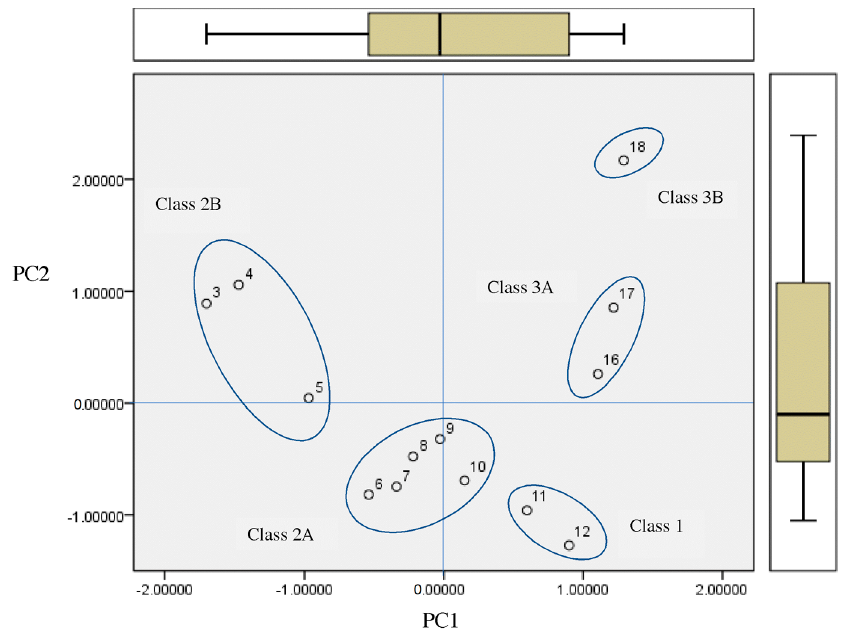
Figure 4. Scores plot for the homologous series of chloromethyl ketones with an acetyl group at R 1